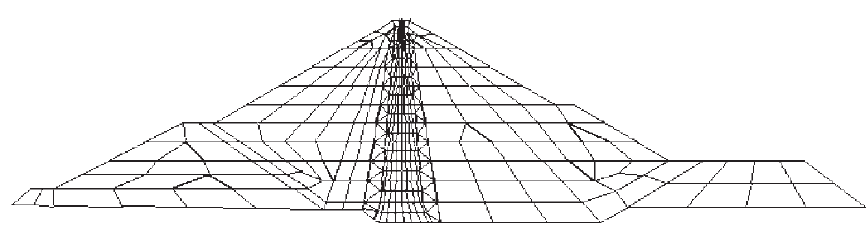
Fig. 9. Mesh geometry of the El Infiernillo Dam adopted in the f.e.m. analysis.